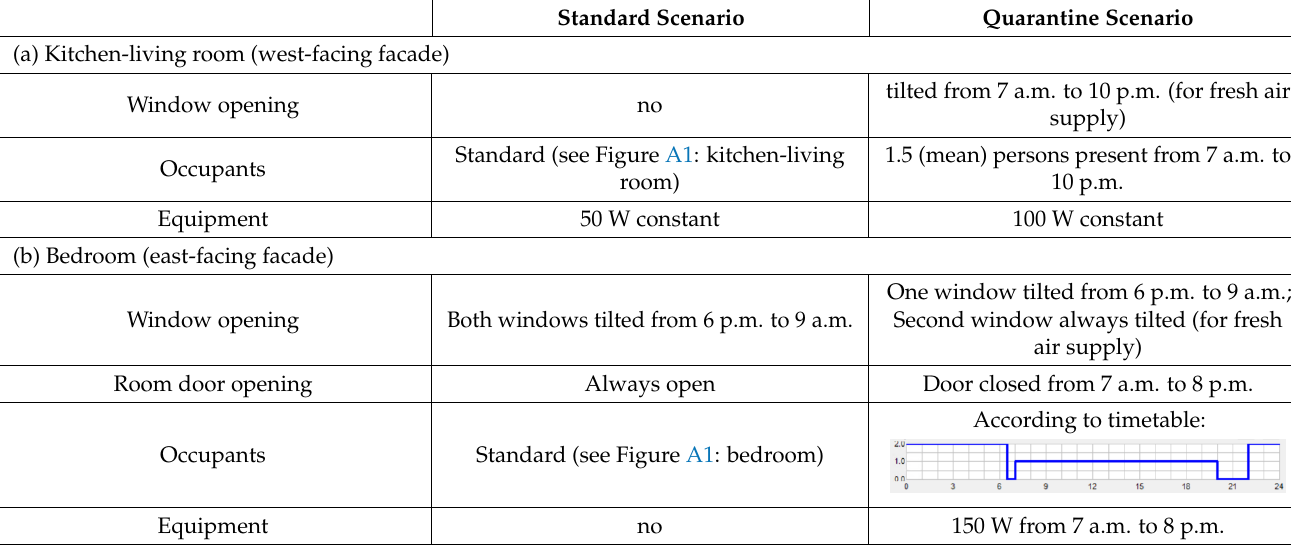
Figure A2. Comparison of measured room temperature and CO 2 -concentration profiles of east and west façade oriented rooms for both top floor dwellings of the GZH building. Table A1. Boundary conditions of dwelling 1 of the top floor for the scenario of residents have to remain in quarantine compared to the standard scenario of absence of residents during daytime.